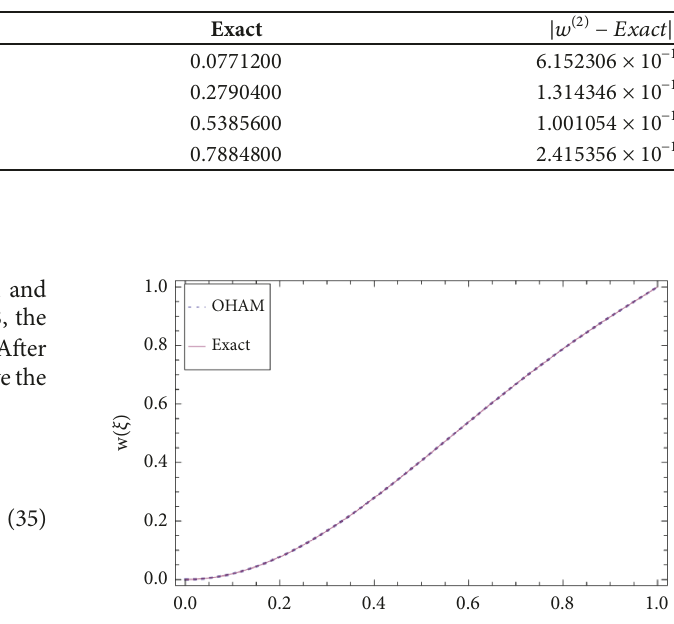
Table 3: Comparison of second-order OHAM solution with the exact solution for example 3.